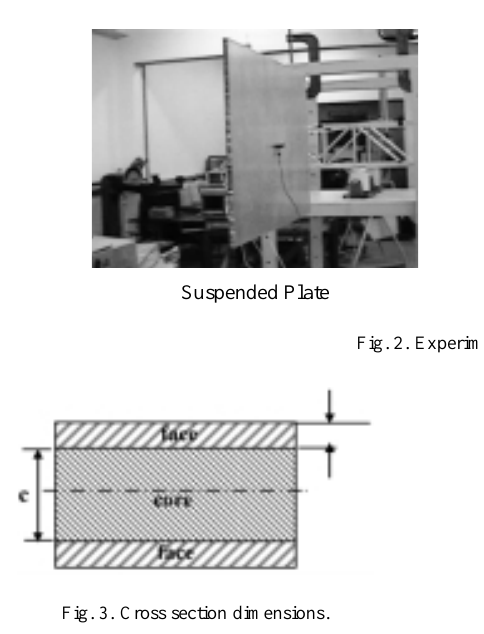
Fig. 3. Cross section